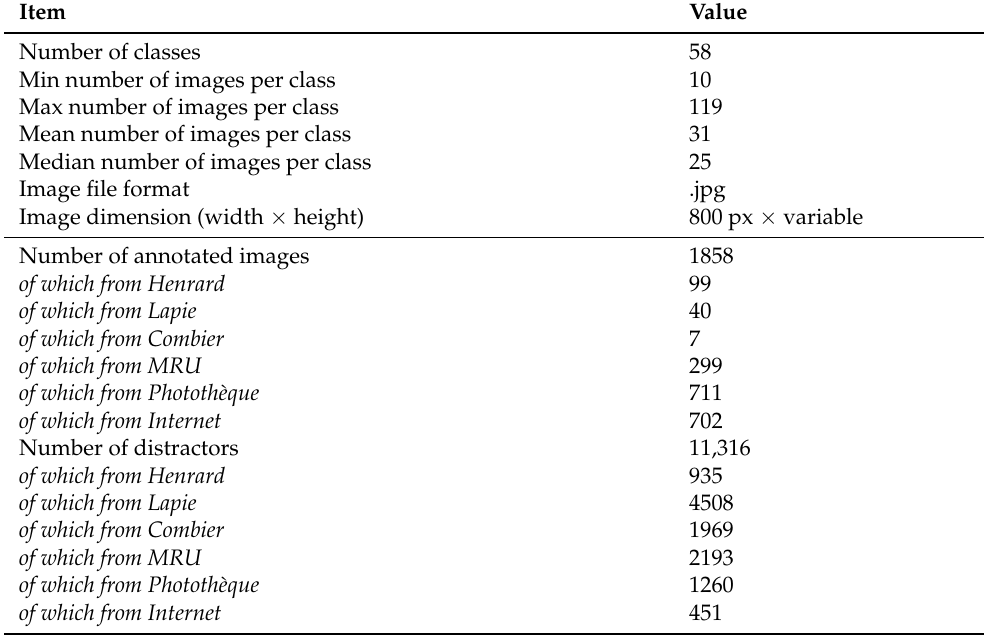
Table 1. ALEGORIA benchmark